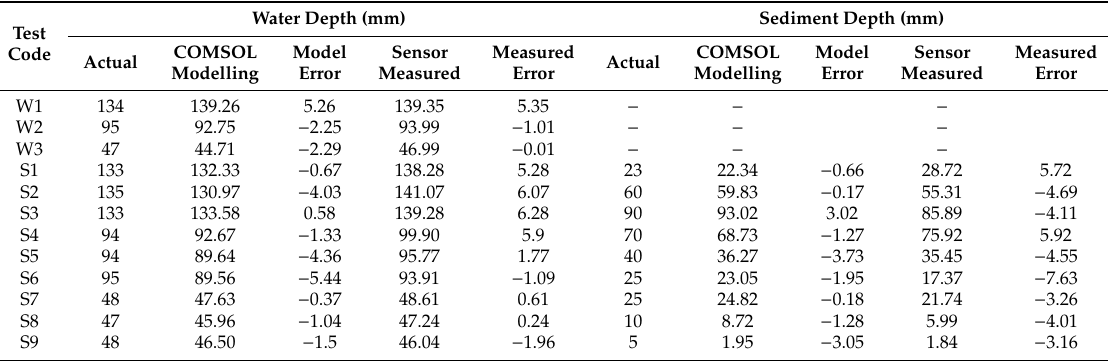
Table 3. Depth results summary of water only tests and water and sediment test.